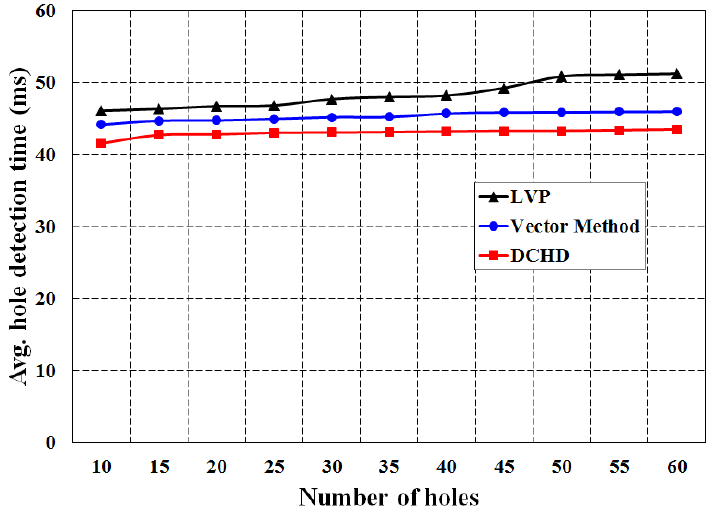
Figure 12. Comparison of DCHD with other protocols in terms of the average hole detection time.